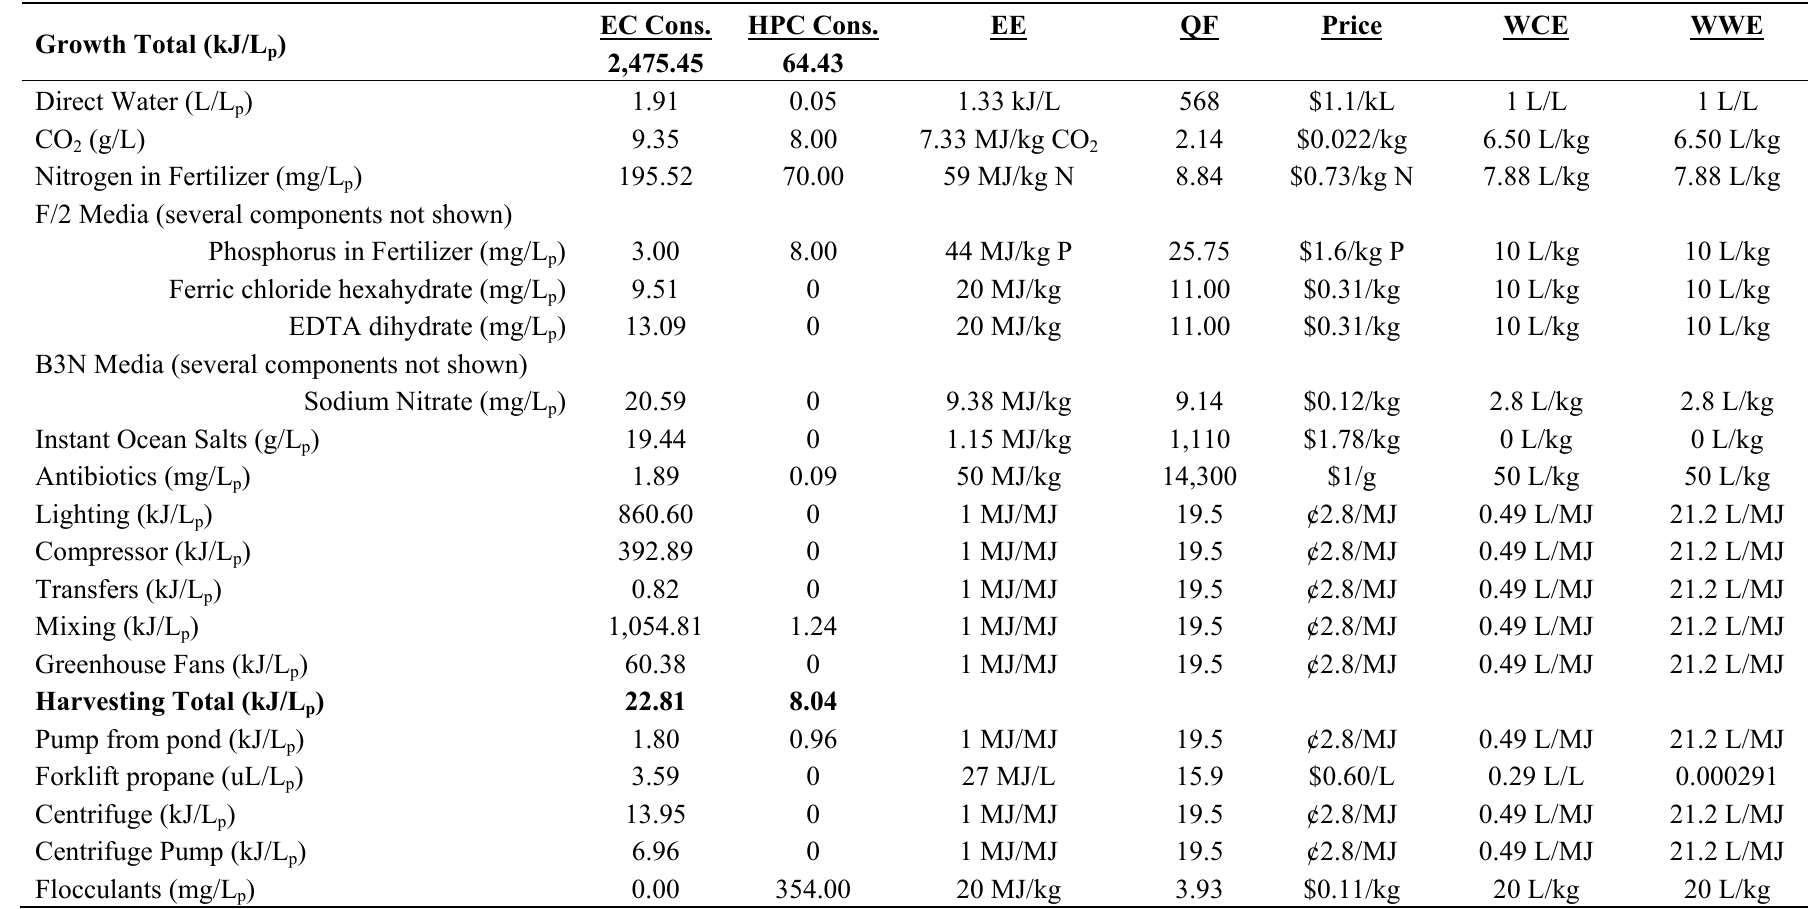
Table 1. Raw data used to calculate the second-order EROI, PFROI, WCI (water consumption intensity), WWI (water withdrawal intensity), and resource constraints in this study. The abbreviations in this table are: EC Cons.— Experimental Case Consumption, HPC Cons.— Highly Productive Case consumption, EE—energy equivalent, QF—quality factor, WCE—water consumption equivalent, WWE—water withdrawal equivalent. References for these data are presented in the tables below where